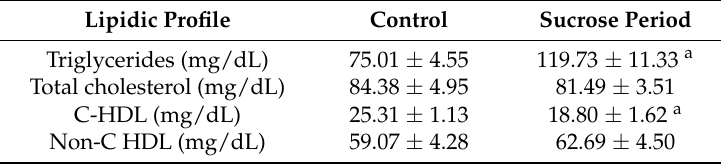
Table 3. Lipidic profile in control and sucrose period